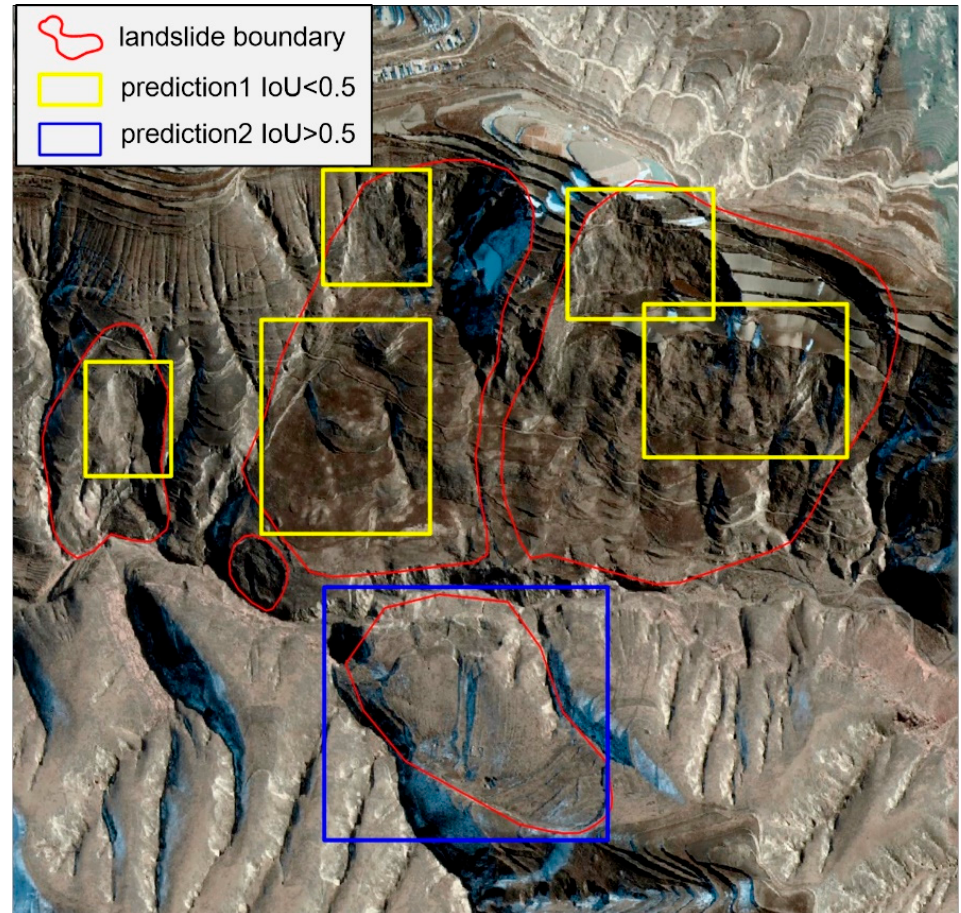
Figure 4. Results of a multi ‐ stage landslide.